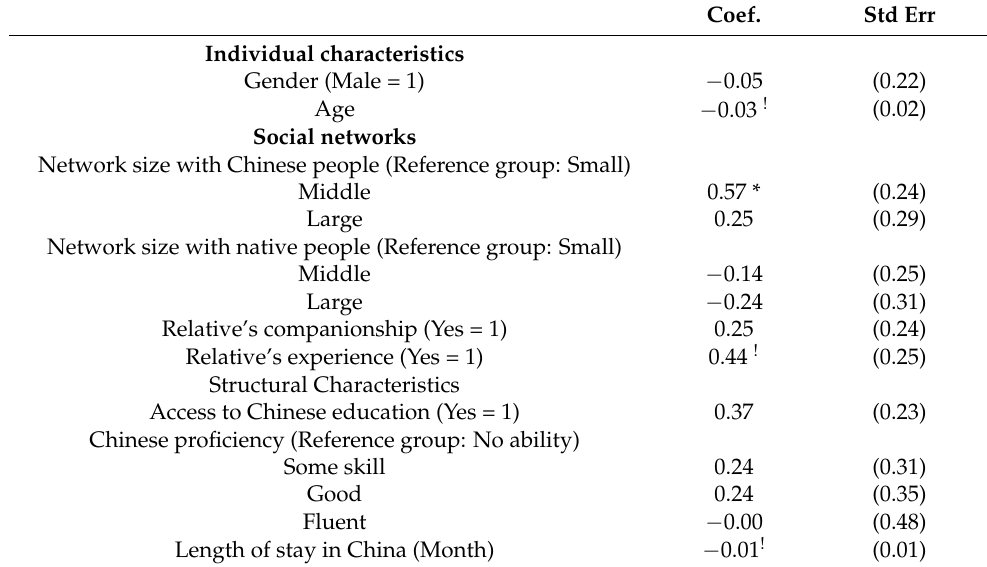
Table 5. Long-term Residence Intention Model. (Logit Regression Model).